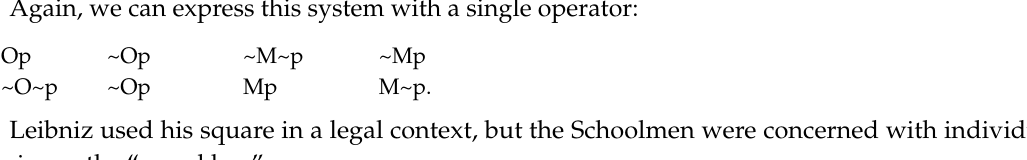
Figure 6. The square of opposition.